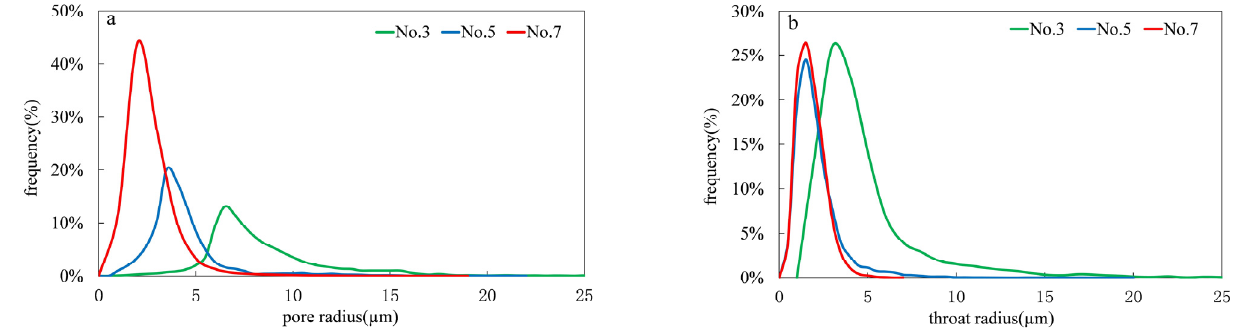
Figure 4. The pore size distributions ( a ) and the throat size distributions ( b ) of the three chosen samples. Table 4. Pore-throat size distribution information.